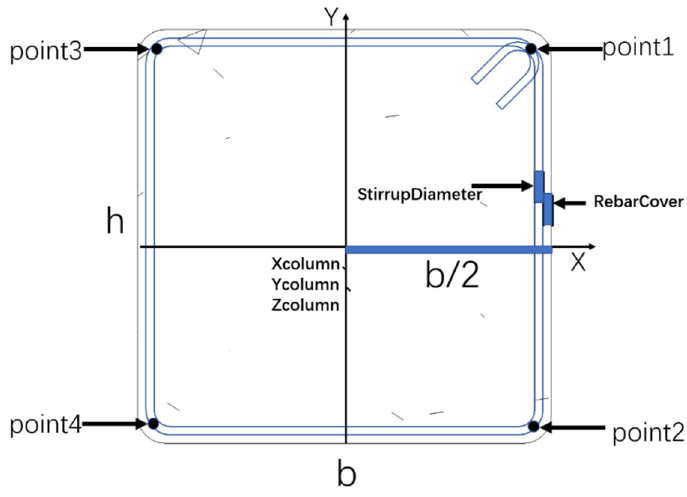
Figure 5. Schematic diagram of stirrup coordinate calculations.